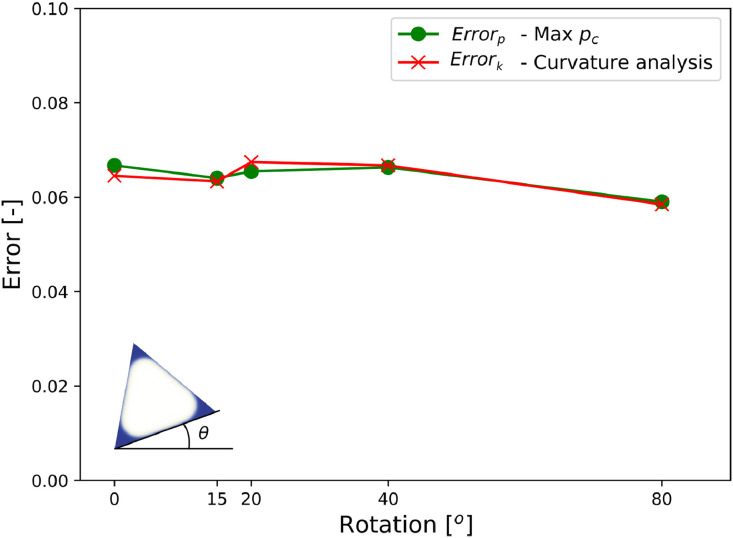
Error on pressure and curvature versus orientation of the throat (relative to LBM grid). pc*=pcLγ.